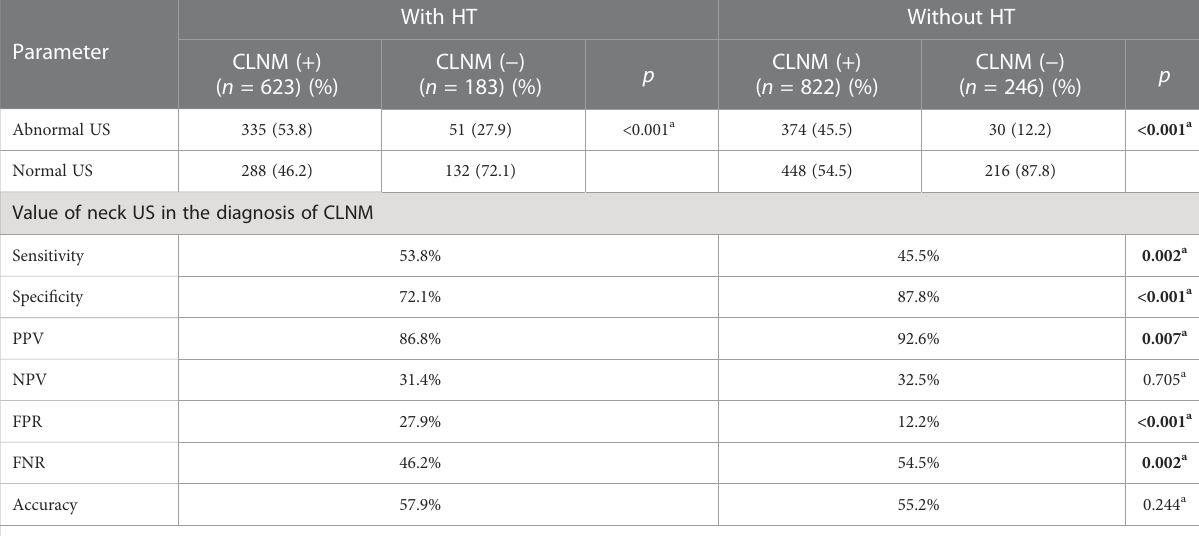
TABLE 2 The diagnostic value for central compartment lymph node metastases in PTC patients with or without HT on neck US.